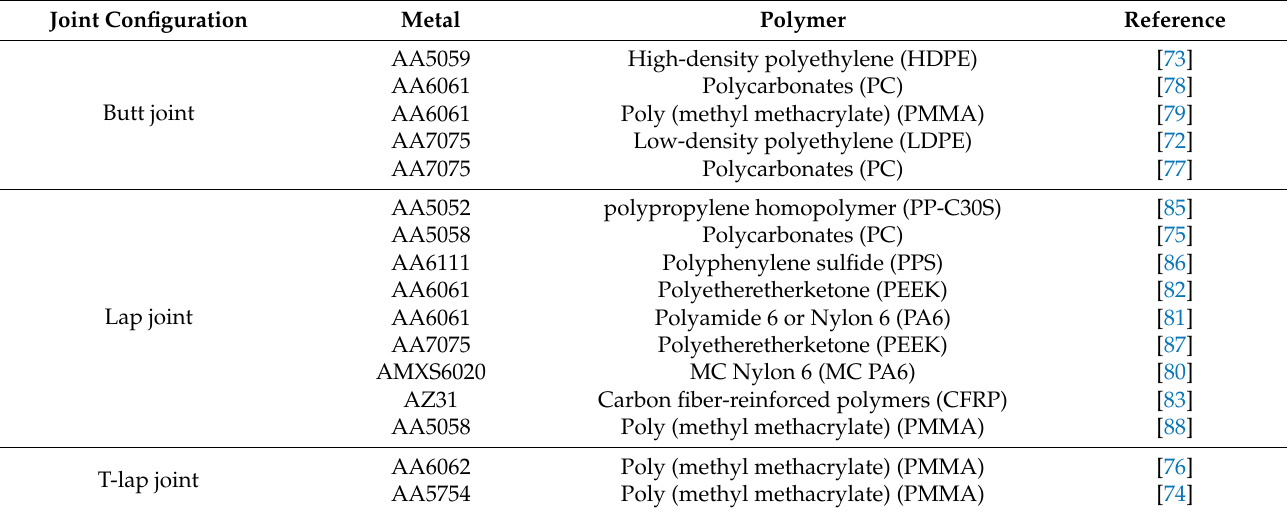
Table 3. Hybrid metal-to-polymer joints reported in the